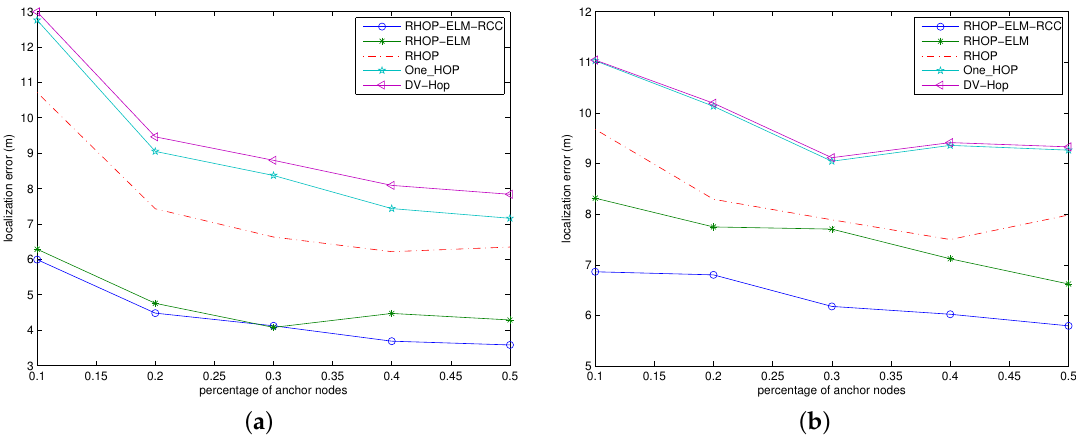
Figure 5. Localization errors against the amount of anchor nodes. ( a ) The case with 50 nodes in the area of 50 m × 50 m; ( b ) The case with 100 nodes in the area of 100 m × 100